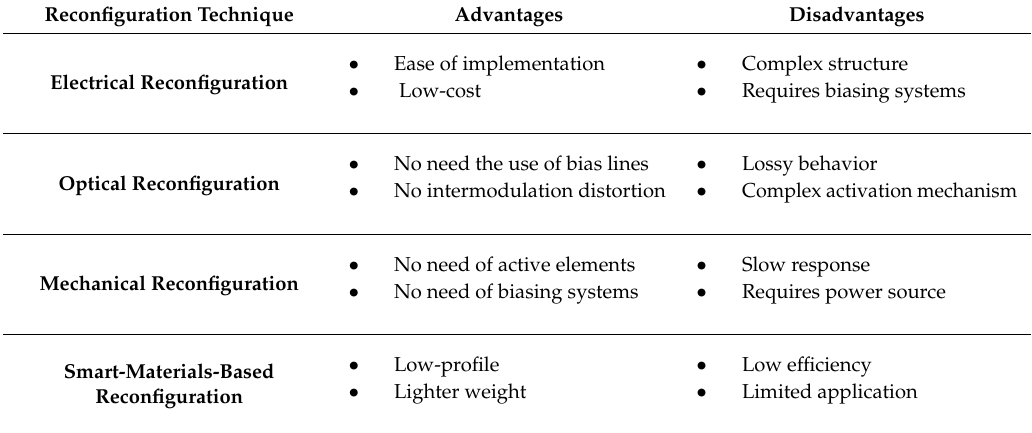
Table 3. Advantages and disadvantages of di ff erent reconfiguration techniques